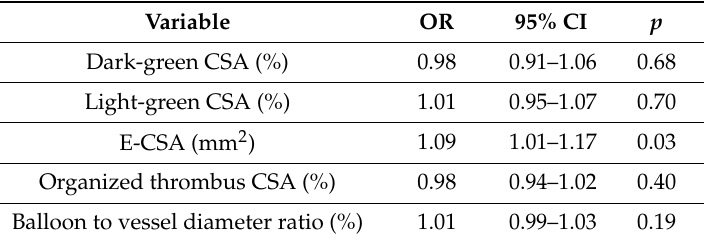
Table 3. Multivariable logistic regression analysis for the prediction of stretch response (type A mechanism) to balloon pulmonary angioplasty (BPA).